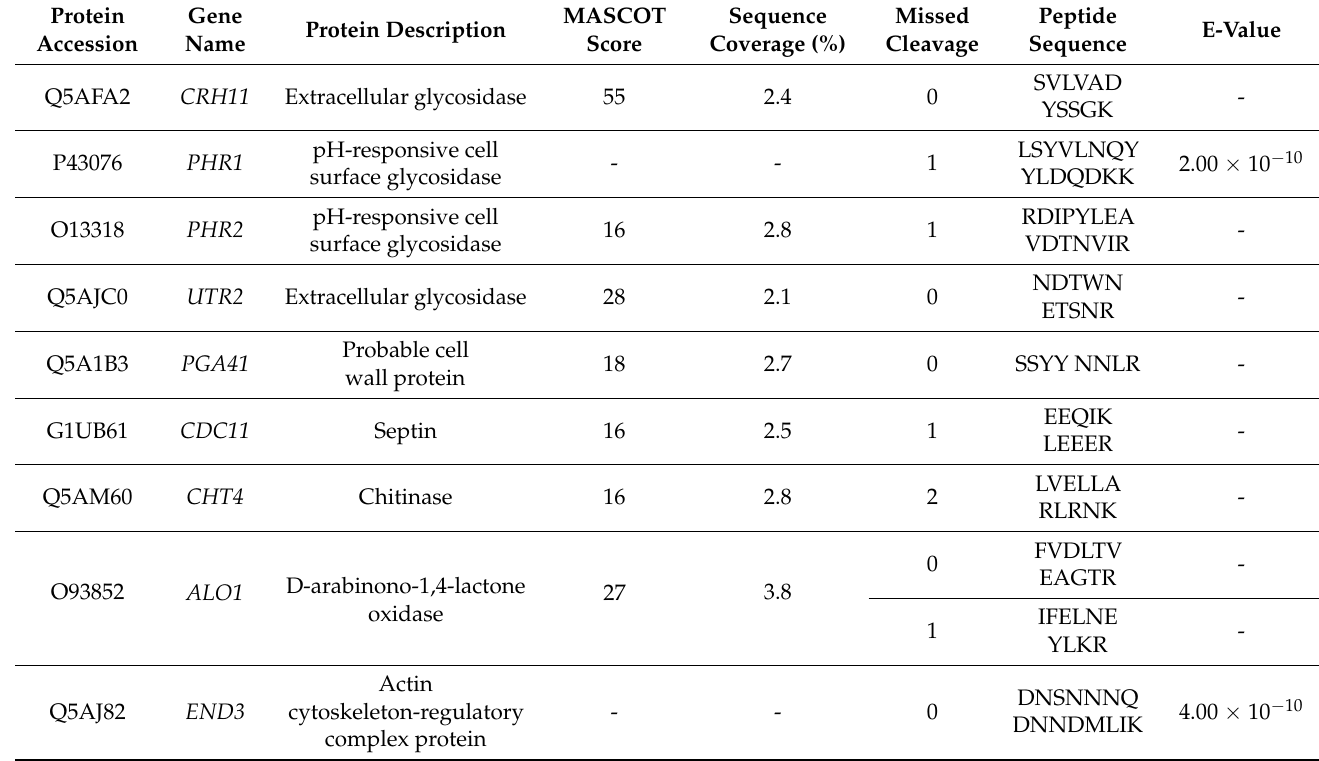
Table 3. Proteins involved in cell wall integrity and chitin content were identified in the fluconazole-resistant C. albicans strain. Proteins identified using MASCOT are represented with sequence coverage while proteins identified using BLAST are represented with